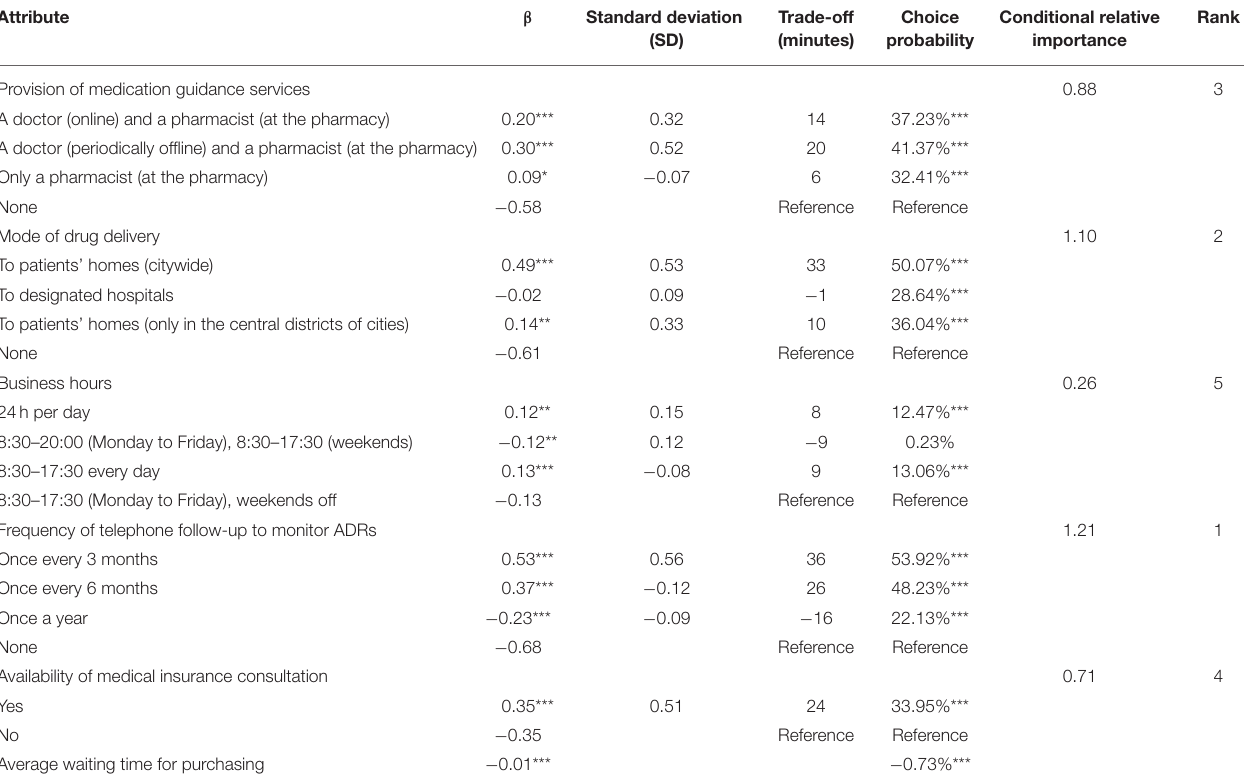
TABLE 3 | Results of the mixed logit